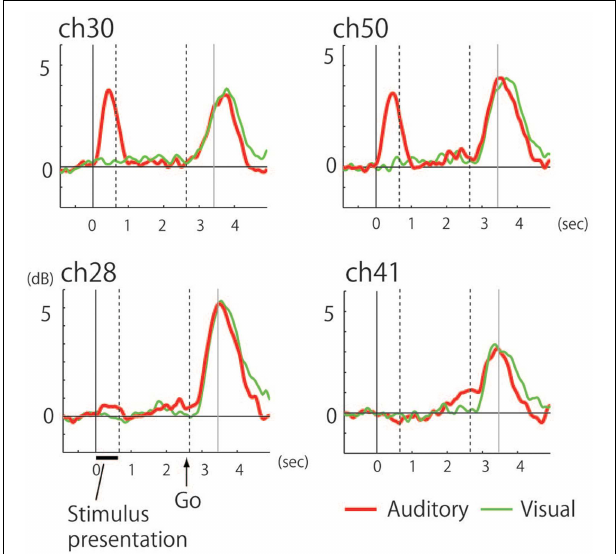
FIGURE 3 | Power curve in the 60–140Hz band under auditory (red) and visual(green)conditions. Indicating (upperrow) biphasicresponseswiththe auditory-selective response accompanied by the motor response (Channels 30 and 50) and (lower row) monophasic responses with purely motor responses (Channels 28 and 41). The end of stimulus presentation is indicated by the dotted line at 0.65s while the other dotted line indicates the timing of the “Go” signal at 2.65s. Gray line indicates mean voice onset time of the subject’s